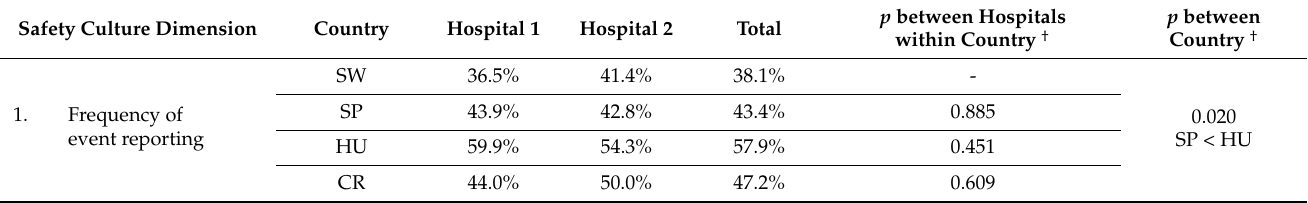
Table 1. Positive perception (percentage) for each dimension by hospital and